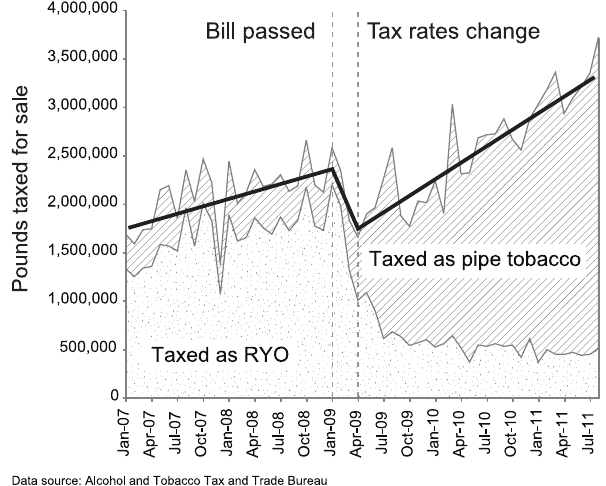
Figure 1. Roll-your-own (RYO) and pipe tobacco sales in the United States, January 2007–August 2011. This stacked area graph shows the total amount of loose tobacco (RYO and pipe tobacco) sales in the United States. The joinpoint fit line shows loose tobacco production was increasing by 15% annually prior to January 2009, mainly due to increases in RYO sales. Loose tobacco production dipped after the Federal tax increase was enacted, but only until the new tax rates went into effect in April 2009. Since April 2009, loose tobacco production has increased by 31% annually, twice as fast as before the tax was